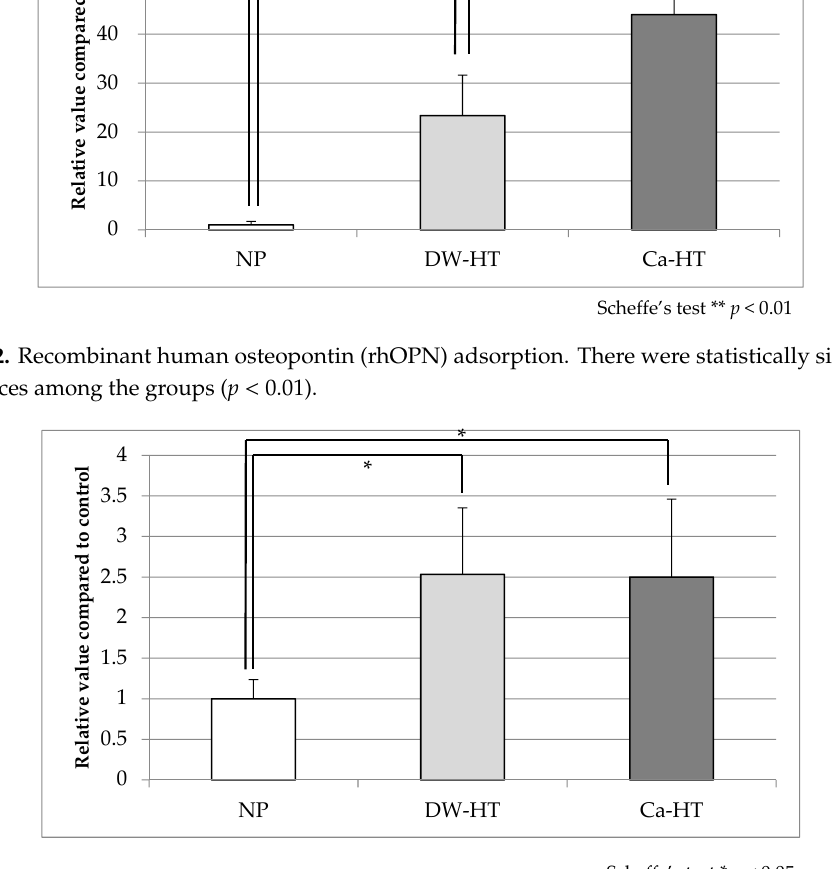
Figure 3. Bovine serum albumin (BSA) adsorption. BSA adsorption was significantly higher in both HT groups than in the NP group. No statistical differences were observed between the HT groups ( p < 0.05).